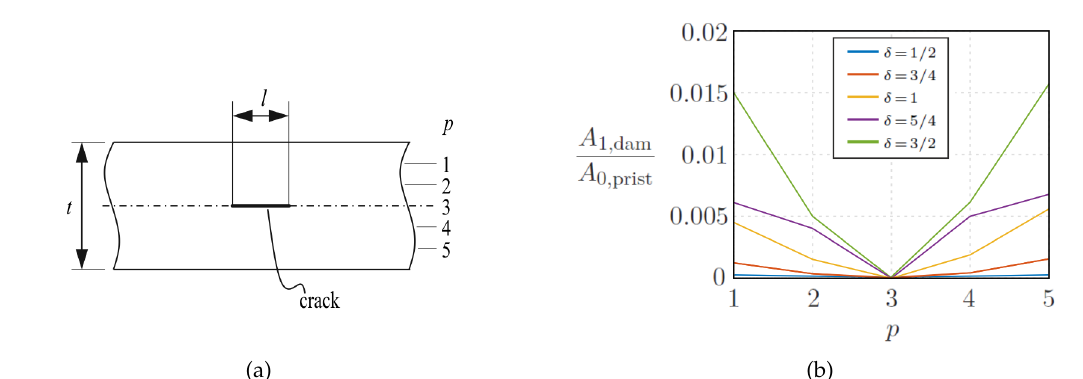
Figure 11. ( a ) Sub-surface crack with position p within thickness t and length l in an isotropic plate. ( b ) Higher harmonic amplitude ratio A 1,dam / A 0,prist comparing wave packets in damaged and pristine conditions. The ratio is drawn for sub-surface cracks with different ratio δ = l / t and evaluated at a distance of 125mm after the wave packet has passed the crack [26].